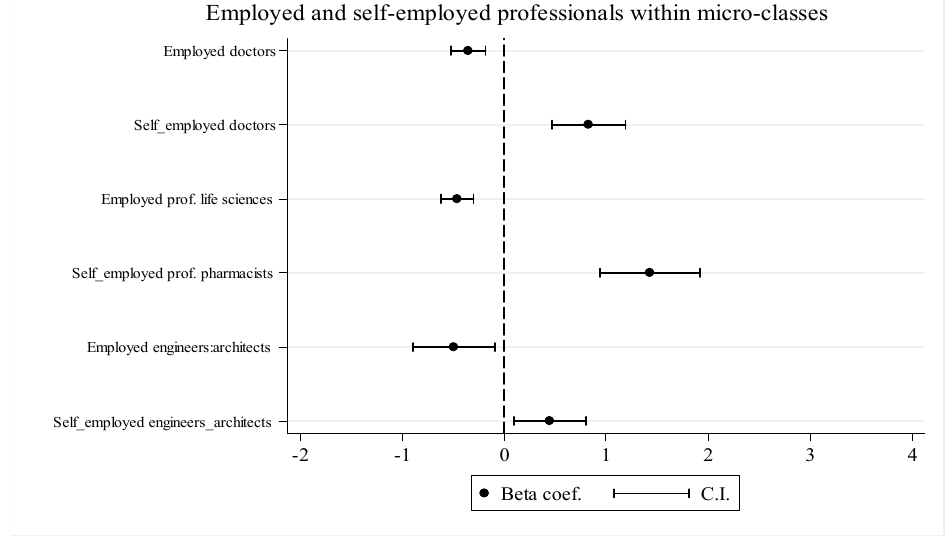
Figure A1. Beta parameters for micro-class social immobility specifying between self-employed and employed within each micro-class. Beta parameters with confidence intervals are extrapolated from Model 7a.